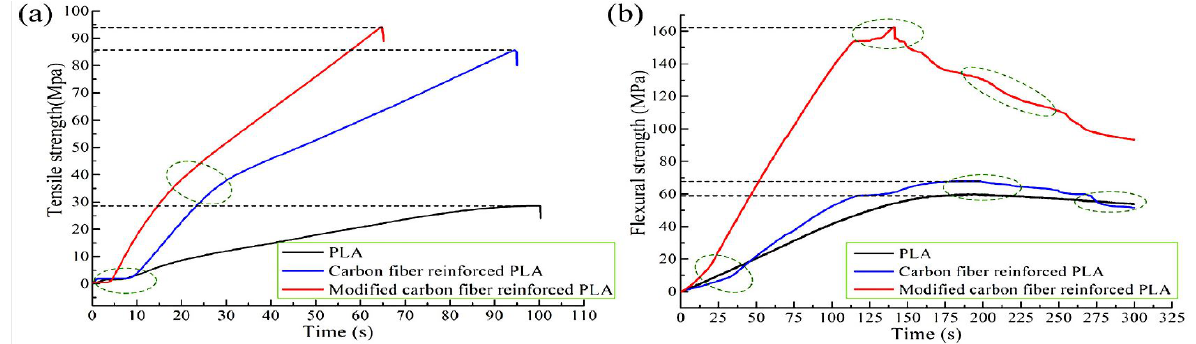
Figure 1. Mechanical properties of modified carbon fiber with methylene dichloride solution reinforcement compared to normal carbon fiber reinforcement and pure PLA; black dashed lines indicate ultimate strength and green circled regions signify different phases of tensile and bending process. ( a ) tensile strength; ( b ) flexural strength